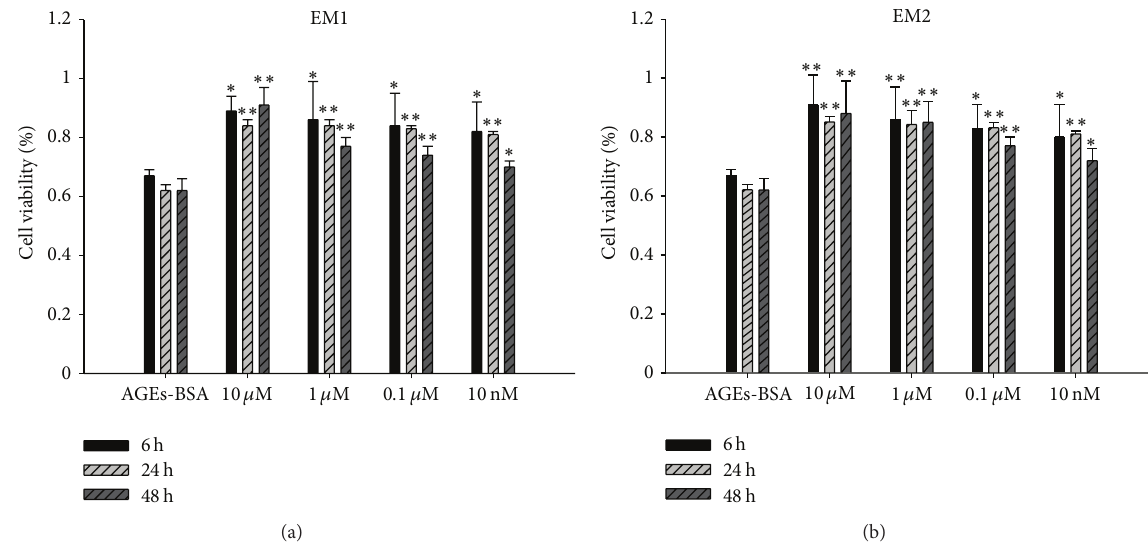
Figure 2: Effect of EM1, EM2 on cell viability determined by MTT test. HUVECs were treated with EMs (10 𝜇 M, 1 𝜇 M, 0.1 𝜇 M, 10nM) for 2h before treatment with AGEs-BSA (100mg/L) for 6 h, 24h, 48h. Viability was calculated as the percentage of living cells in treated cultures compared to those in control cultures. Each value represents the mean ± SD ( 𝑛 = 3 ). Statistical analysis compared with AGEs-BSA group by ANOVA. ∗ 𝑃 < 0.05, ∗∗ 𝑃 < 0.01 .